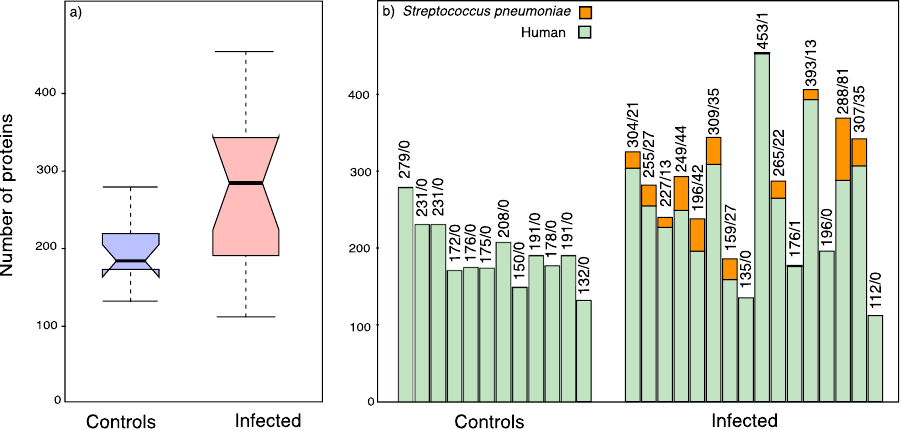
Figure 1. Proteome profiles of control and infected CSF samples. For each sample, protein discovery analysis was performed on a fixed volume of CSF from control (n = 12) and infected individuals (n = 16). (Panel a) Box plots analysing the number of protein groups obtained in control (blue) and infected (red) samples. Top and bottom of the box represent the 75% (Q3) and 25% (Q1) percentile, the line inside the box represents the median and whiskers define 1.5 times the interquartile range from the box. (Panel b) Number of host and pathogen proteins identified per sample. Each column expresses the number of human proteins identified in the sample (green) and the number of S. pneumoniae proteins